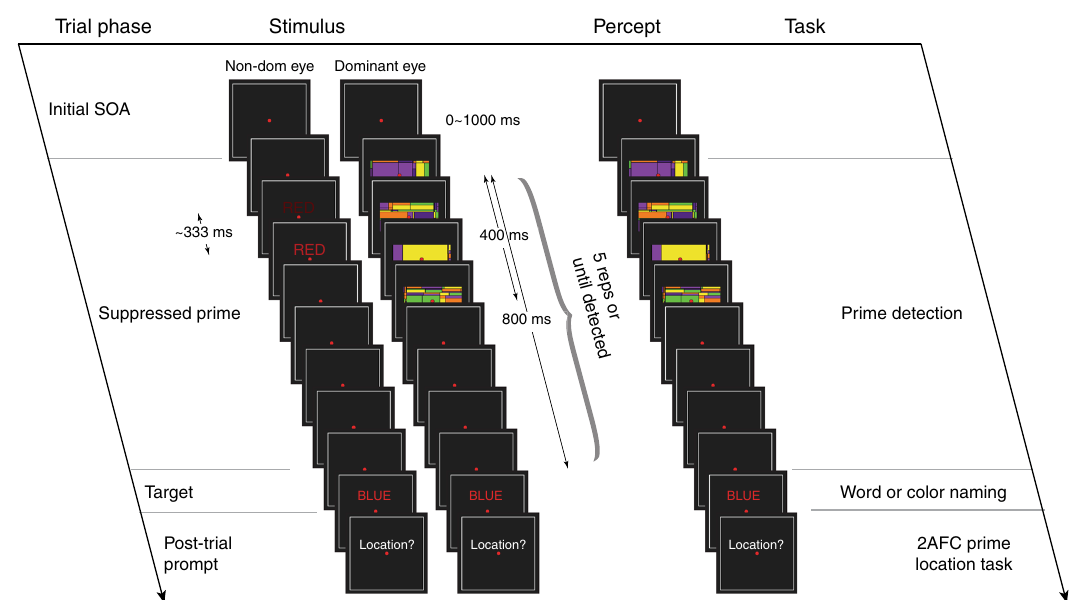
Fig. 1 Trial sequence, stimulus, and task. Each trial was self-paced and began with a varied stimulus-onset asynchrony (SOA) ranging from 0.1 – 1s. After which a dynamic fl ashing colored Mondrian pattern was presented to the dominant eye while the colored word prime was presented to the non-dominant eye. During 400 ms suppression period, the suppressed word was sandwiched by the Mondrian pattern by two frames at each end, leading to 333 ms presence. The 400-ms-on-400-ms-off pattern was repeated fi ve times or until participants reported breakthrough. If breakthrough was reported, the trial ended immediately. If not, another colored word was presented immediately until response. Participants were instructed to name the word (Experiments 1, 3, and 5, 7) or color (Experiments 2, 4, 6, 8) of the target. A 2-alternative-force-choice location task was present at the end of each trial, participants were instructed to report the location of the suppressed prime. While the prime detection served as a subjective report of prime visibility, this location task served as a post-trial objective gauge of prime visibility. The prime was occasionally superimposed on the Mondrians (visible catch) or simply non-existent (blank catch). Refer to Table 2 for detailed prime-target combinations in all experiments. The prime and target were of different font sizes and presented on slightly jittered locations.